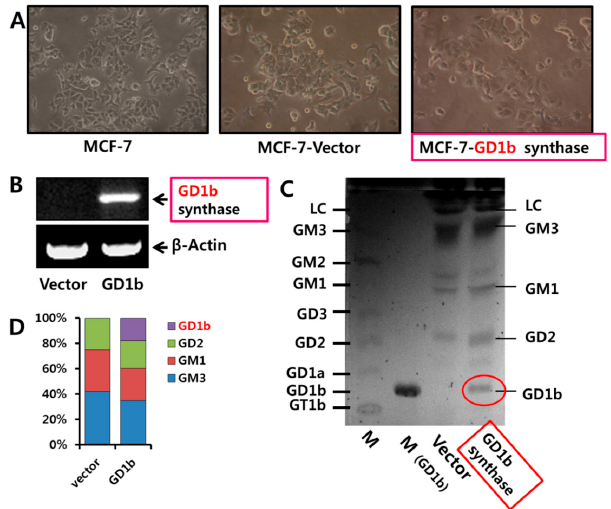
Figure 5. Establishment of GD1b synthase-transfected MCF-7 cell line. ( A ) Effect of GD1b synthase transfection on MCF-7 cells morphological changes. Morphological changes of MCF-7, vector- (pcDNA 3.1 vector) and GD1b (pcDNA 3.1 vector/GD1b synthase)-transfectant cells were observed under a phase-contrast microscope with 100×; ( B ) Expression levels of GD1b synthase of vector- and GD1b-transfectant cells were analyzed by RT-PCR. β -Actin was used as the internal control; ( C ) Gangliosides contents in vector- and GD1b-trnasfectant cells were analyzed by TLC; ( D ) Comparison of ganglioside contents in Mock (vector-transfected) MCF-7 cells and GD1b synthase-transfected MCF-7 cells. Percentage of each ganglioside was measured by densitometry with total gangliosides of each lane as 100%.